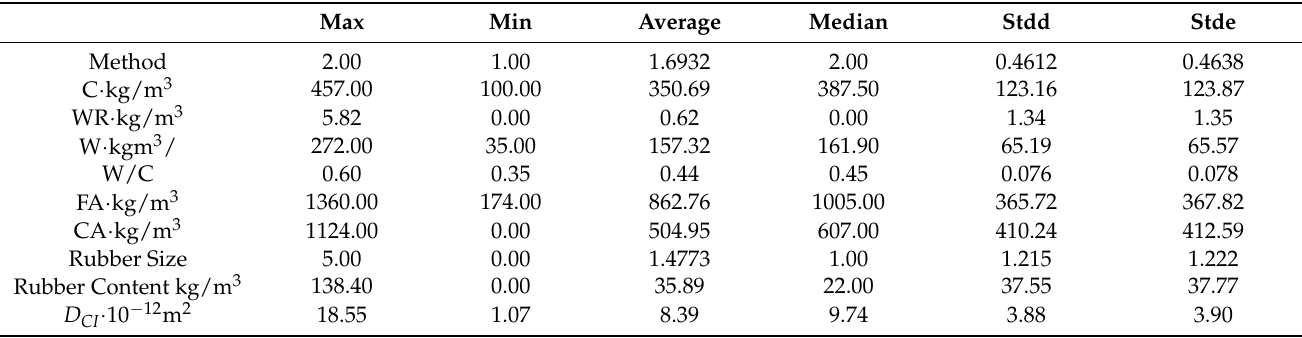
Figure 2. Histogram of frequency distribution for input and output variables. Table 1. Statistical analysis of input and output variables.